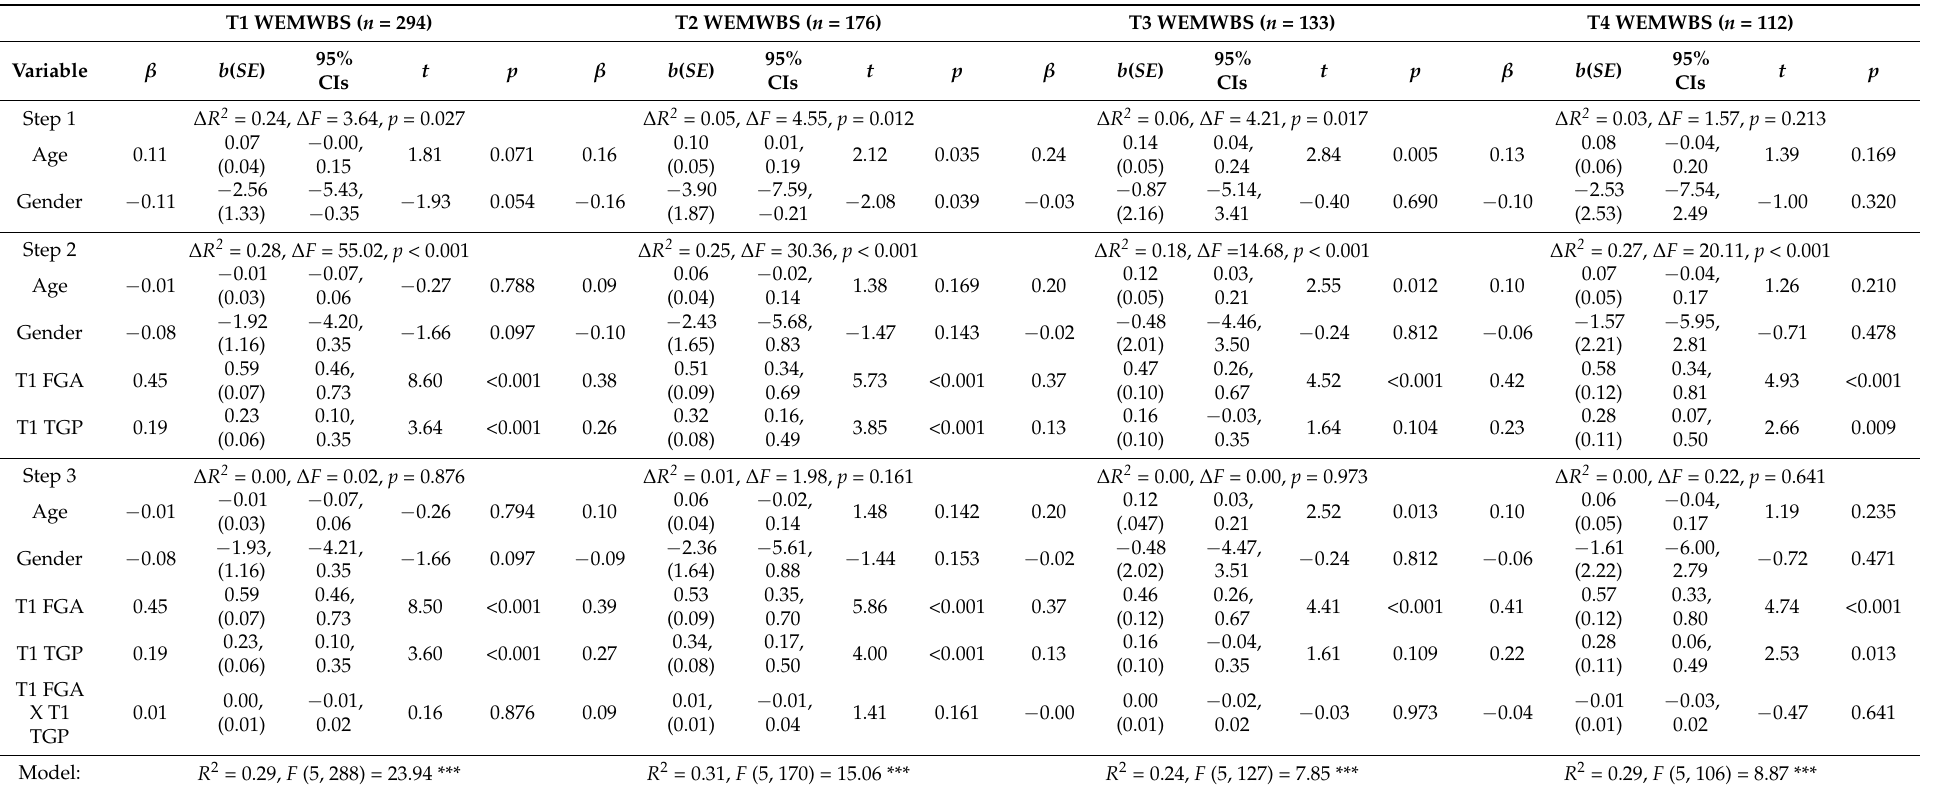
Table 2. Tenacious goal pursuit and flexible goal adjustment as predictors of mental wellbeing from Time 1 to Time